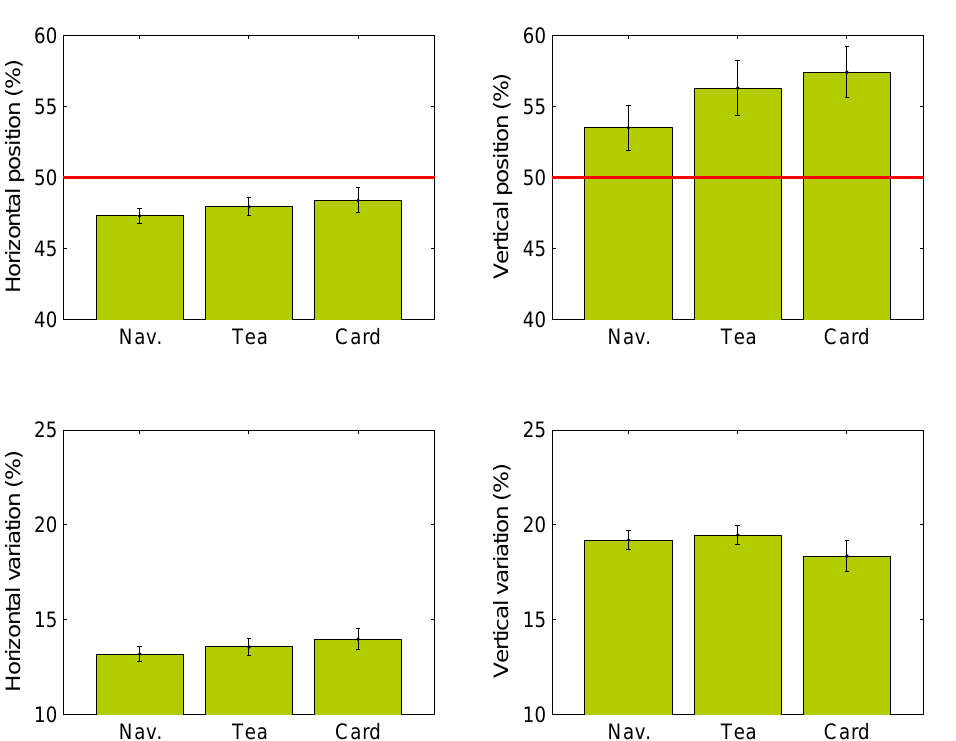
Figure 4 . Average gaze location and standard deviations across the three tasks (plotted such that horizontal averages above 50% indicate a gaze bias towards the right and vertical averages above 50% indicate a gaze bias towards the top section of the video image). Separate data plots show the average location (as a percentage of the width or height of the video image) and standard deviation of the locations (first computed per participant and then averaged). The red horizontal lines indicate the center of the image. Error bars show the standard error of the mean across